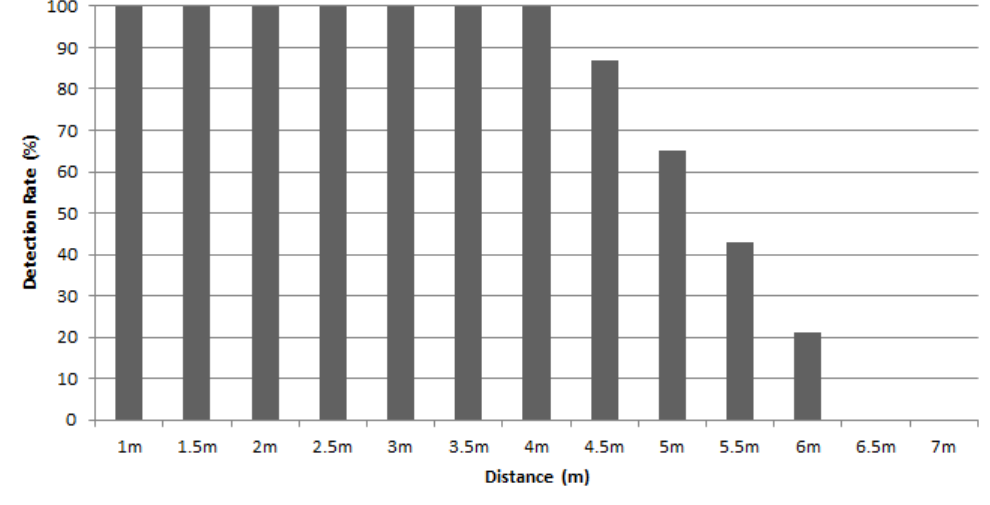
Figure 8. Detection rate according to a distance from 1 to 7 m.